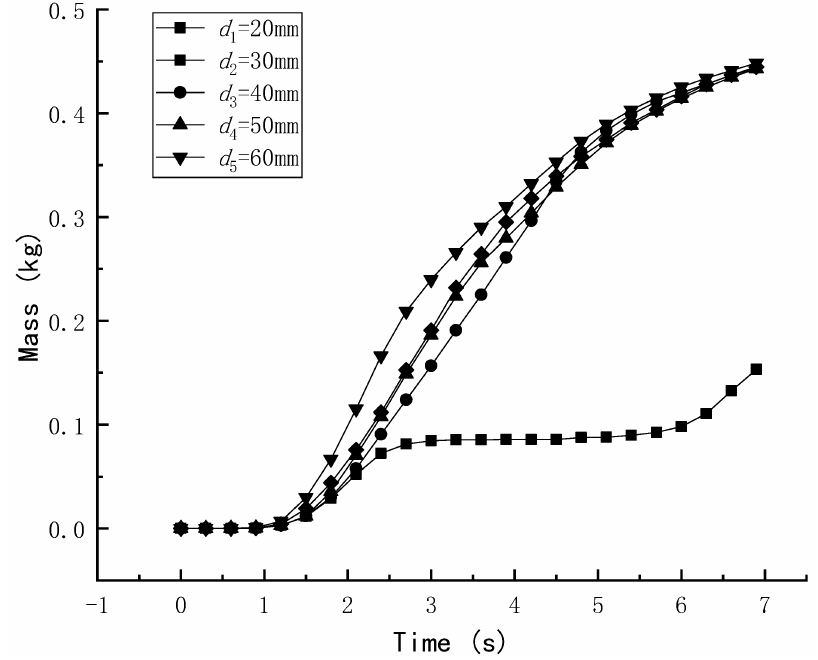
Figure 9. Variation curve of rice-filling mass with different funnel diameters.